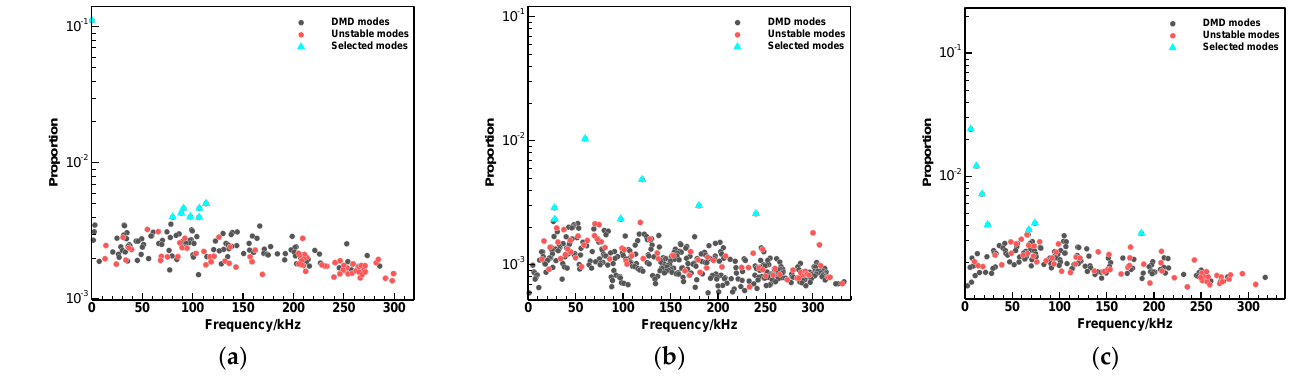
Figure 14. Distribution of mode frequency and energy: ( a ) Case 1; ( b ) Case 2; ( c ) Case 3.